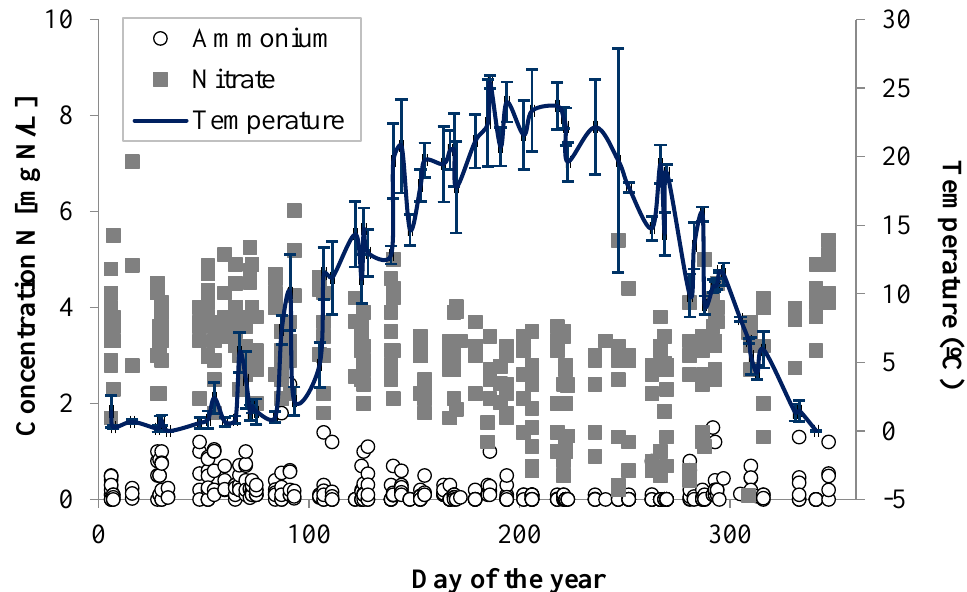
Figure 5. Ammonium and Nitrate concentration (mg N/L) and river temperature in the Central Grand River from 2010 to 2013. Data represents location from 98 km from headwaters (West Montrose) to 204 km (Brantford).